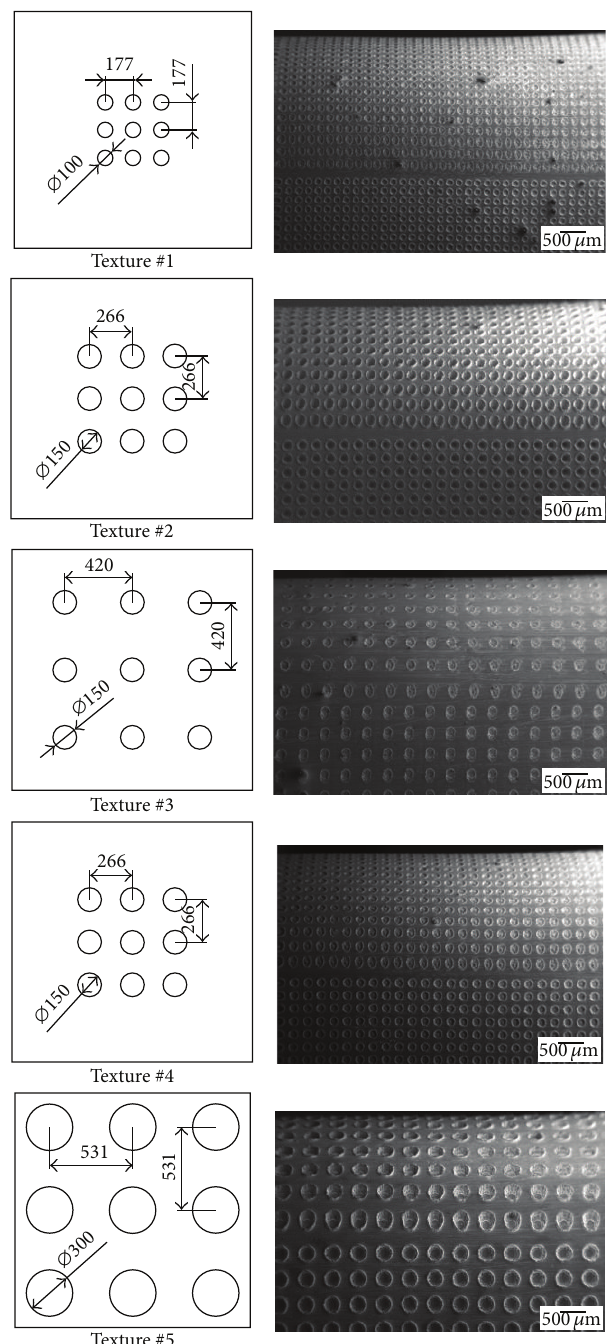
Figure 5: Sketches and SEM images at the die radius of the five textures before stamping tests.